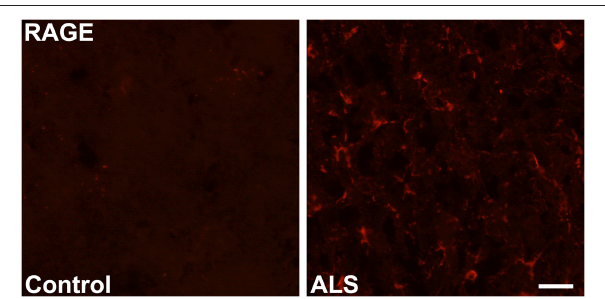
FIGURE 1 | Increased expression of RAGE in SOD1 transgenic mouse lumbar spinal cord. Immunohistochemistry: lumbar spinal cord was stained for RAGE using standard immunofluorescent technique in control (left) and SOD1 transgenic ALS (right) mice. Representative images from n = 3 mice/group are shown. Scale bar = 25 µ m. FIGURE 2 | Increased expression of RAGE in SOD1 transgenic mouse